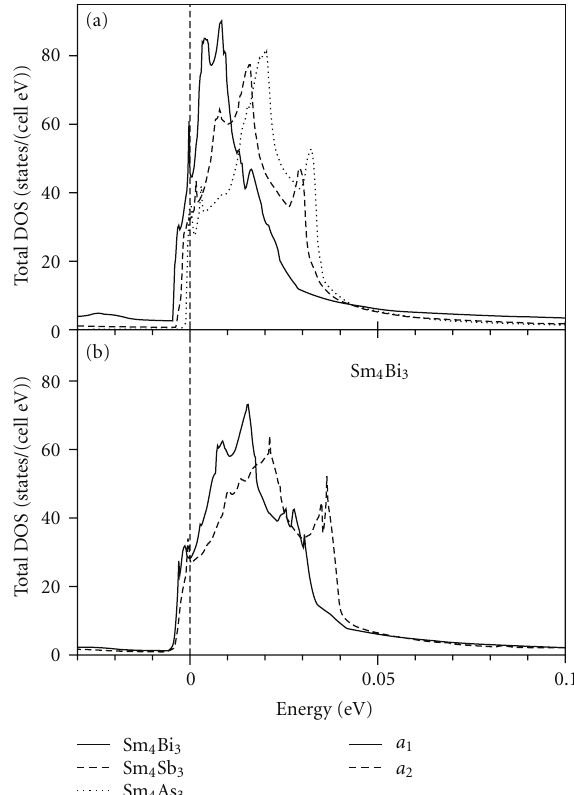
Figure 83: Expanded view of the DOS of (a) Sm 4 X 3 (X = As, Sb, Bi) and (b) Sm 4 Bi 3 for the lattice constants a 1 = 9 . 308 ˚A and a 2 = 9 . 561 ˚A